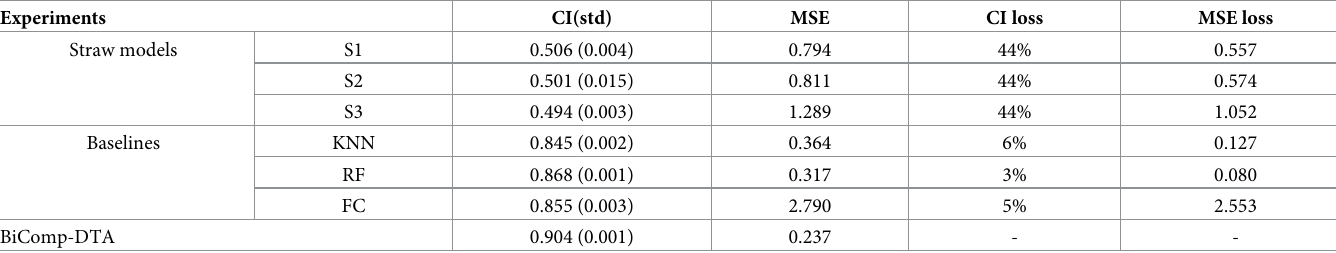
Table 8. Straw and baselines models experiment on BiComp-DTA for the Davis